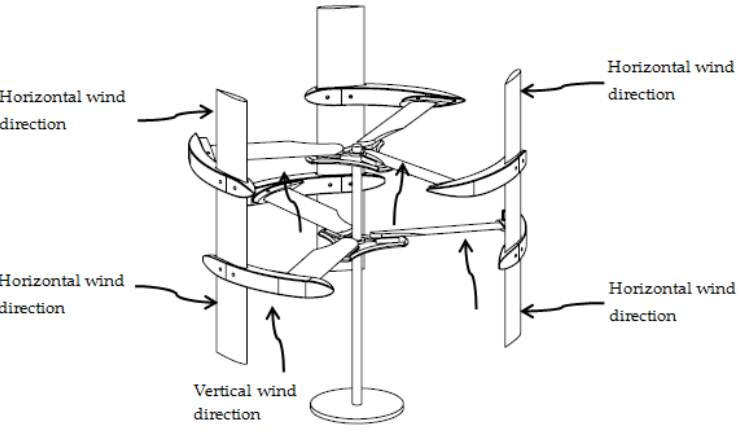
Figure 6. CAWT operating under horizontal and vertical wind directions.